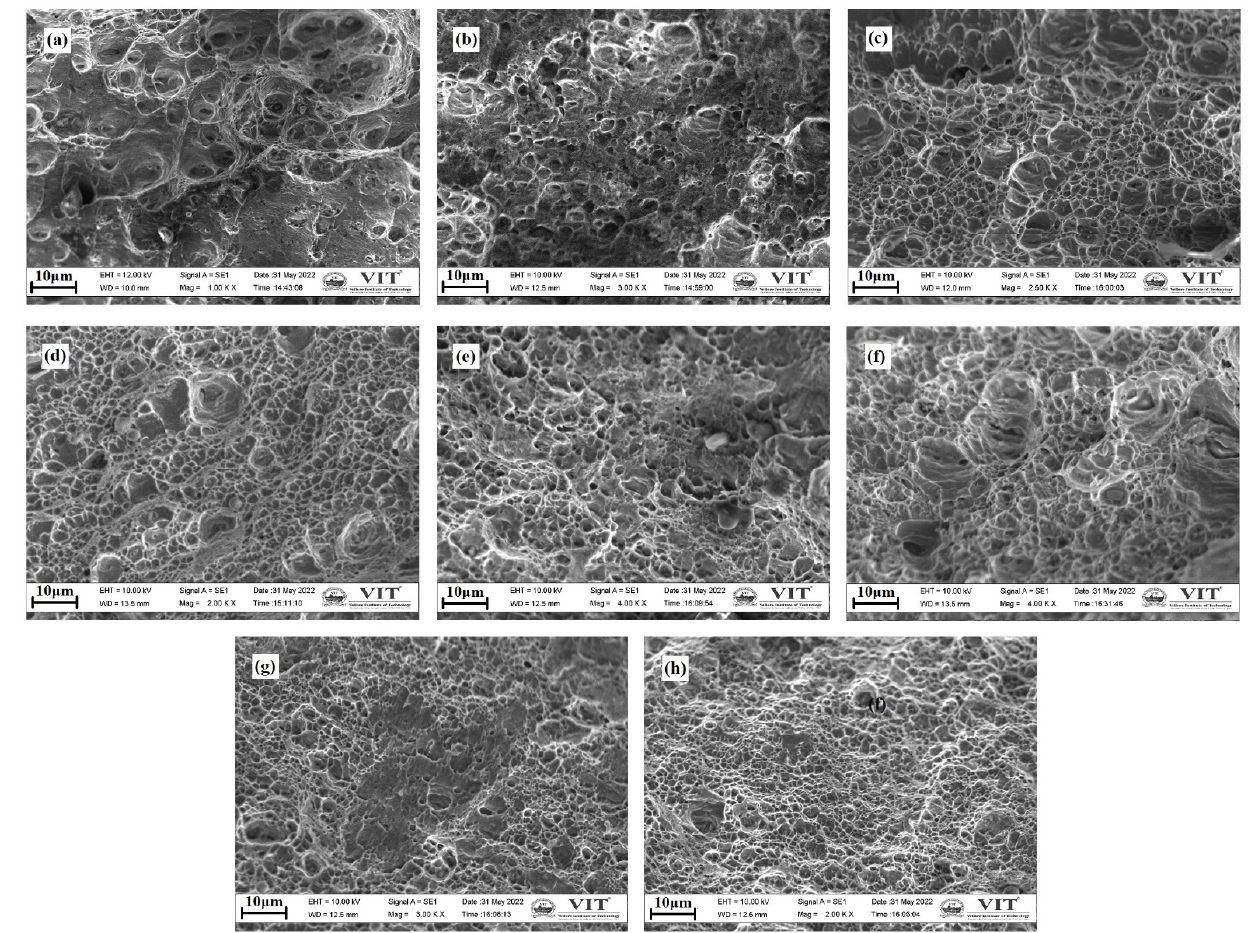
Figure 16. SEM micro images of fractured tensile samples: ( a ) layer 1–2, ( b ) layer 2–3, ( c ) layer 3–4, ( d ) layer 4–5, ( e ) layer 5–6, ( f ) layer 6–7, ( g ) AA6061, and ( h ) AA7075.